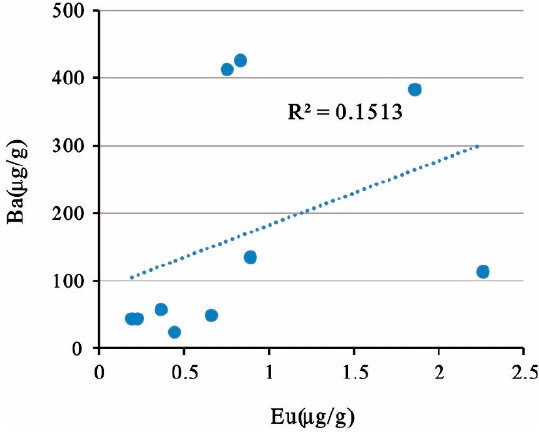
Figure 15. Relationship between Eu and Ba in the Dongpo samples.